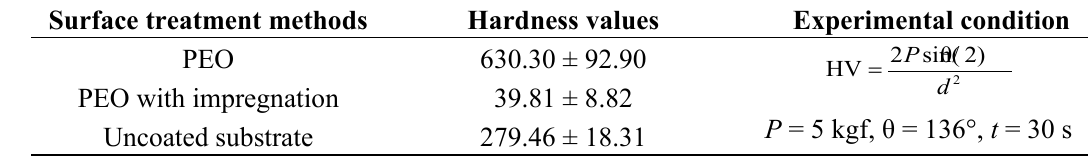
Table 2. Webster hardness under different surface treatment